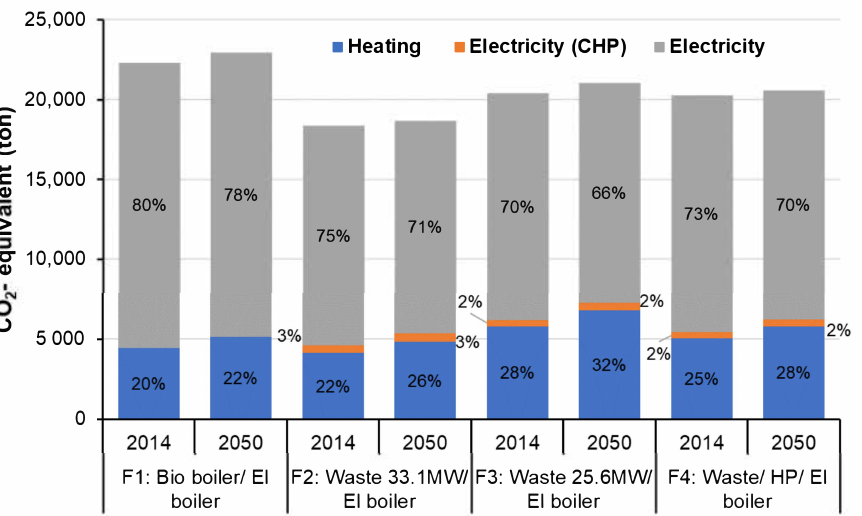
Figure 9. Allocation of the CO 2 emissions for the different energy supply technologies for the increased building stock.